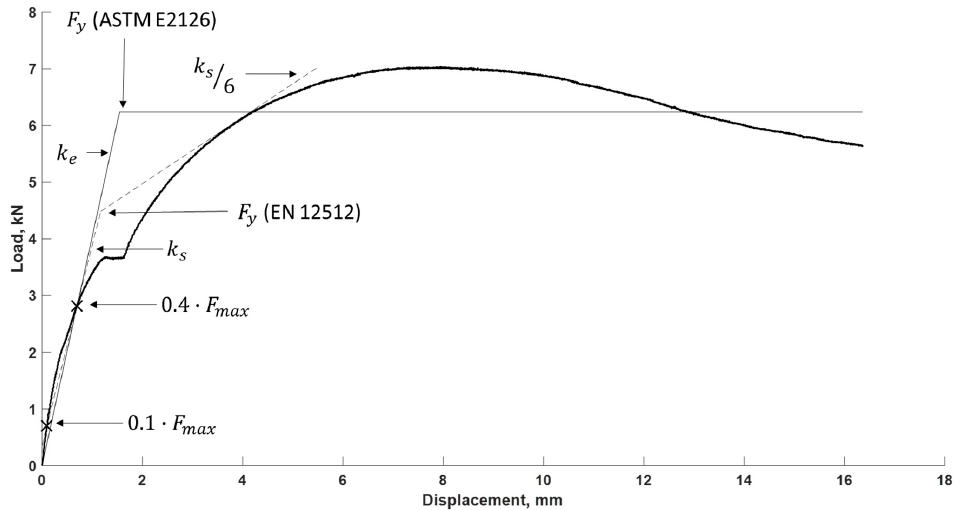
Figure 5. Load–displacement plot of specimen HP2 annotated to show stiffness and yield loads.